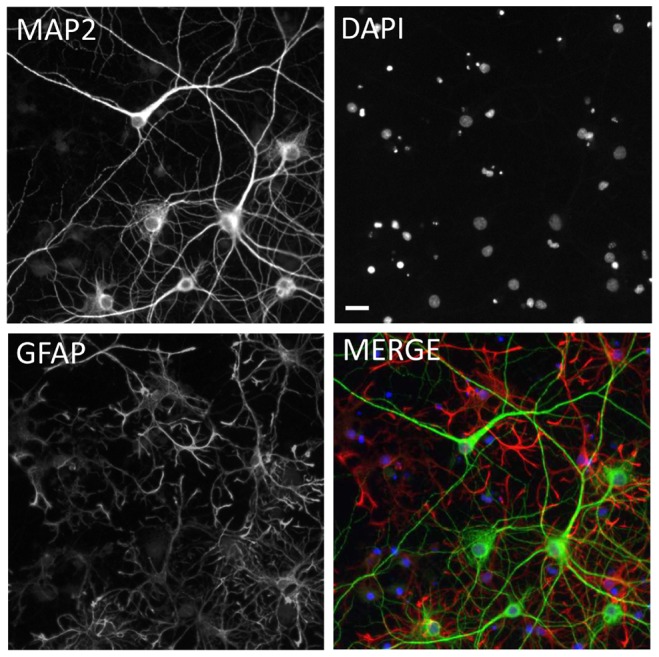
Immunofluorescent labeling of mixed hippocampal/cortical cultures.
A, MAP2 labeled neurons. B, DAPI-labeled nuclei. C, GFAP labeled glia and Nuclei. D, Merged composite of all three images. Based on untreated control wells from 104 experimental plates, the percentage of neurons in the cultures was 26.0±1.1% (Mean ± S.E.M.). Scale bar  = 20 microns.